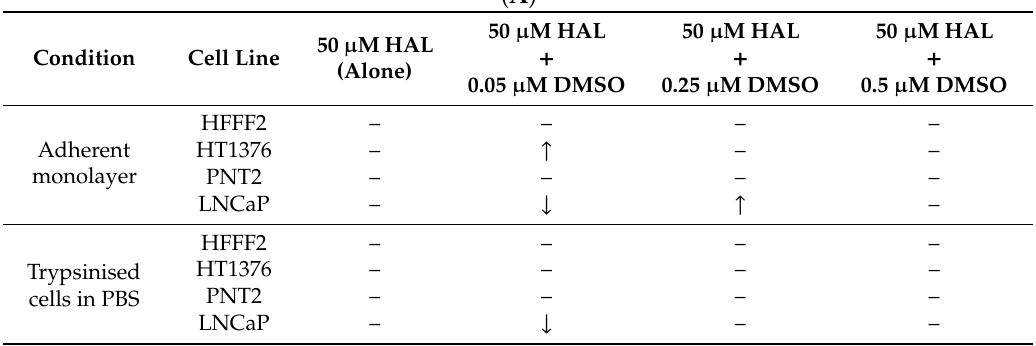
Table 1. Summary of hexaminolevulinate (HAL)-based with dimethylsulphoxide (DMSO) (top) or deferoxamine (DFO) (bottom) treatment for different cell types in all conditions tested.